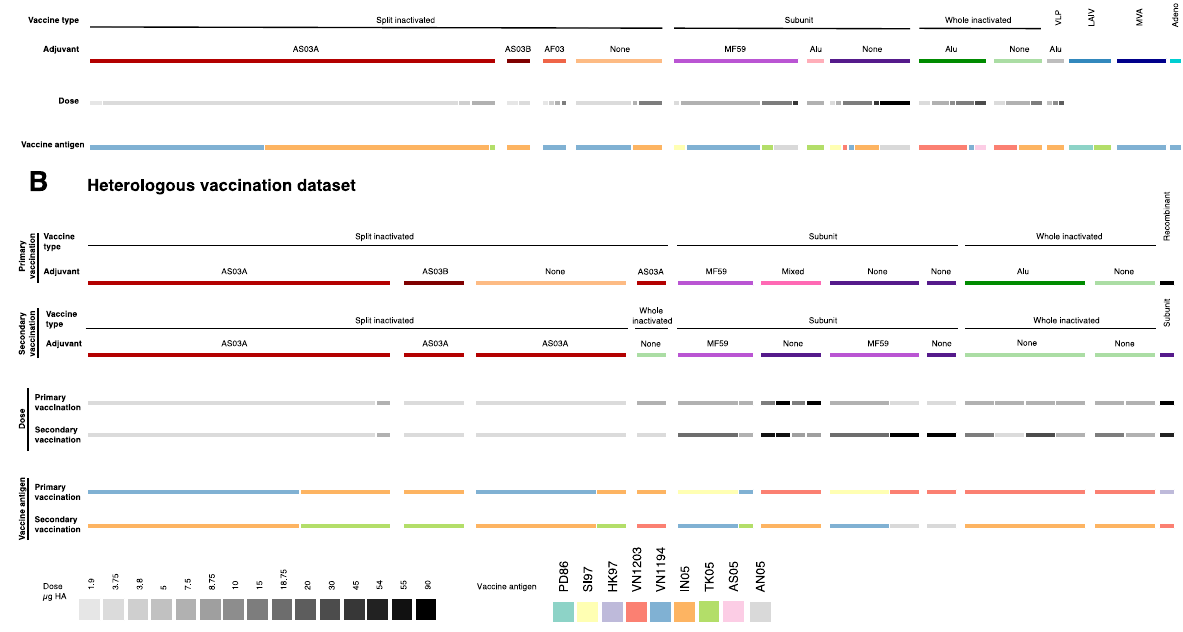
Figure 2. Overview of present dataset. ( A ) Homologous vaccination dataset; ( B ) heterologous vaccination dataset. For each, the width of the bars represents the number of entries in each dataset with the reported characteristics (vaccine type, adjuvant use, amount of HA or vaccine strain). The homologous dataset contained 162 entries and the heterologous dataset contained 60 entries. The ‘mixed’ adjuvant refers to a pooled experimental group where subjects received either aluminum salt adju- vanted, MF59 adjuvanted or unadjuvanted vaccines. Abbreviations: HA: hemagglutinin; PD86: A/Duck/Potsdam/1402-6⁄1986; SI97: A/duck/Singapore/1997; HK97: A/Hong Kong/156/1997; VN1203: A/Vietnam/1203/2004; VN1194: